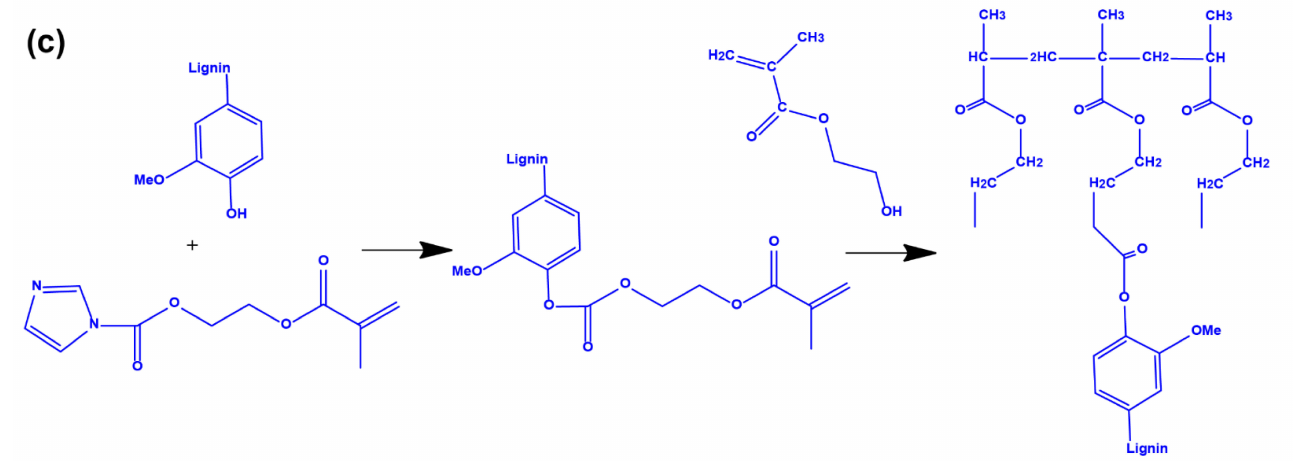
Figure 3. ( a ) Interpenetrating polymer network of lignin and crosslinking monomer. ( b ) Copolymer- ization of lignin and the crosslinking agent. ( c ) Copolymerization of grafted lignin and crosslink- ing